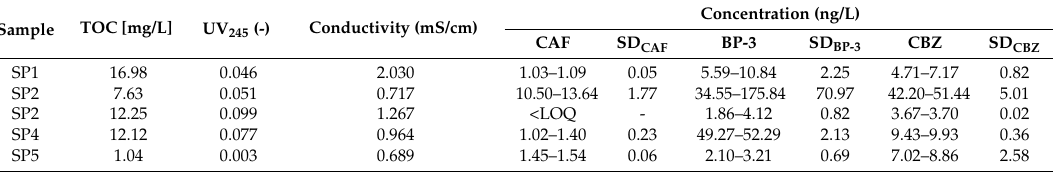
Table 8. Pharmaceuticals and personal care products (PPCPs) found in swimming pools collected throughout the Silesia region in Poland and the measurements of organic and inorganic substance